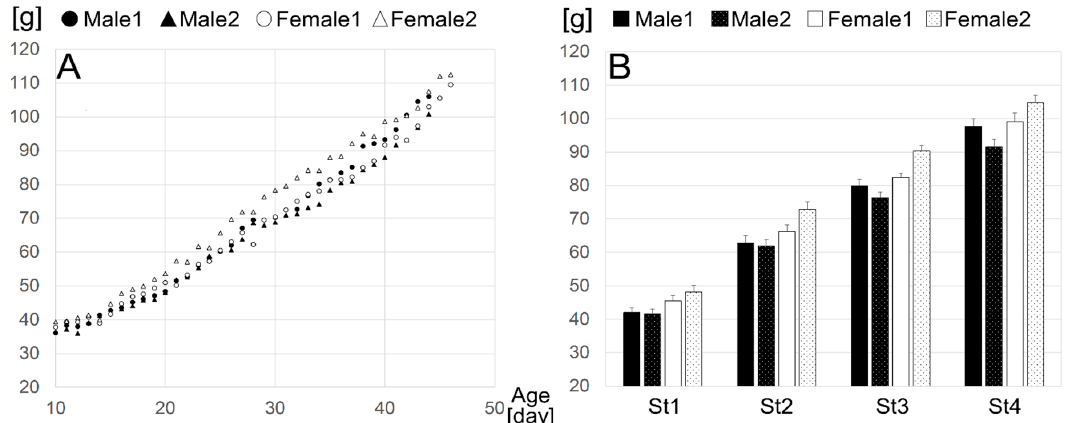
Figure 3. Longitudinal body weight. Body weight by age ( A ) and mean body weight by age stage ( B ). Age stages are St1:P15–22; St2:P23–31; St3:P32–38; St4:P39–45. Error bars indicate s.e.m.